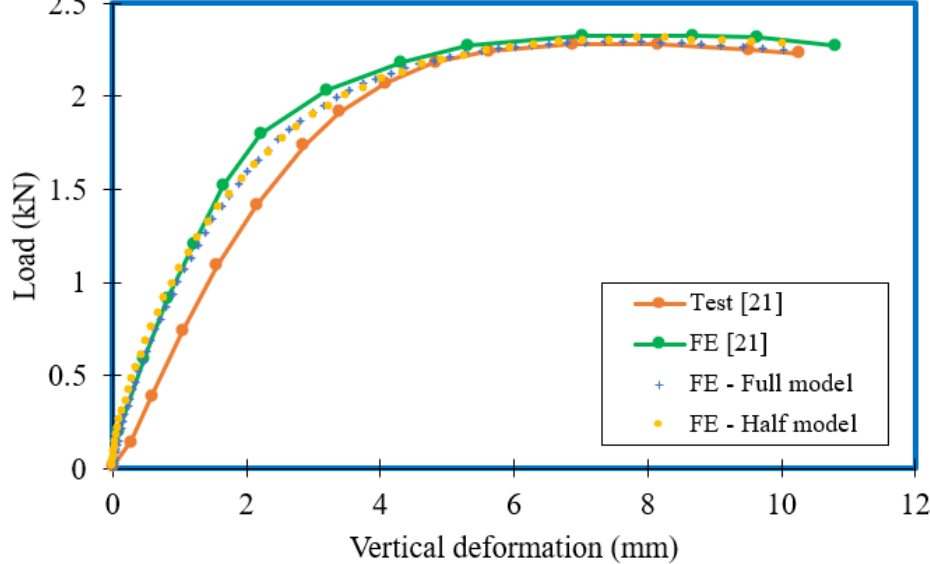
Figure 8. Load–vertical deformation comparison of ETF-UC10012 with 50 mm bearing plate [21].